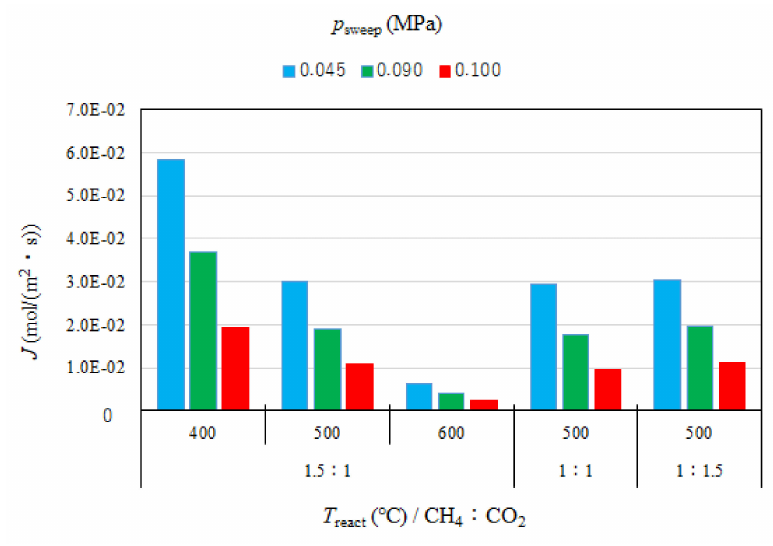
Figure 10. Impact of permeation flux with p sweep , reaction temperature and molar ratios of CH 4 :CO 2